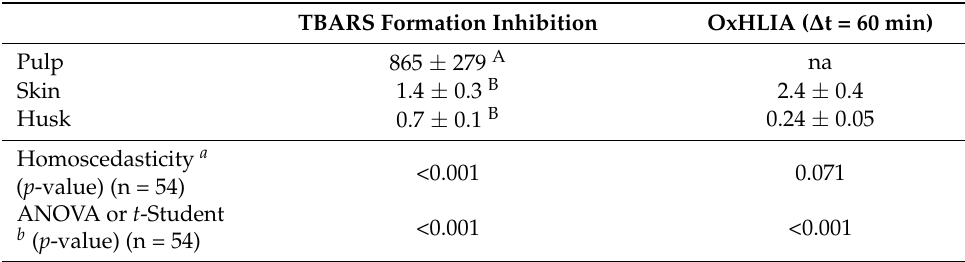
Table 3. Antioxidant activity of pulp, skin, and husk of Aesculus hippocastanum fruits (EC 50 values; µg/mL; mean ± SD).